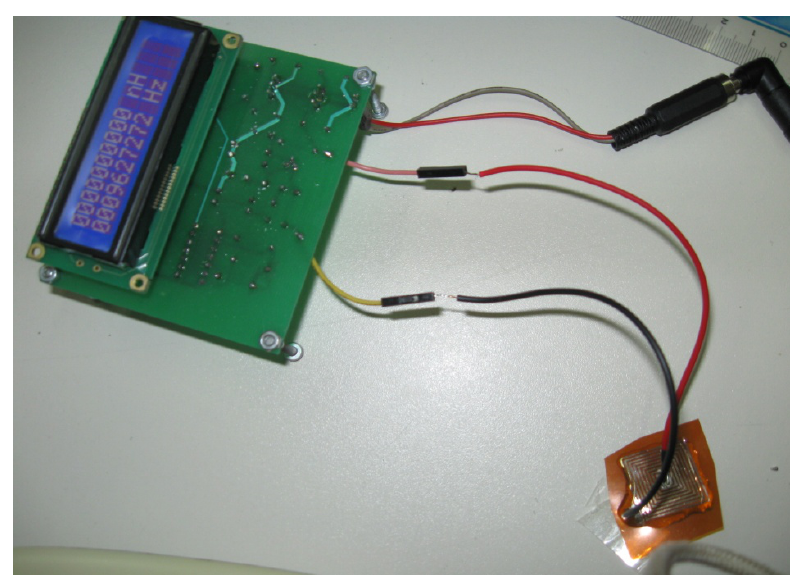
Figure 12. Complete sensor without target.